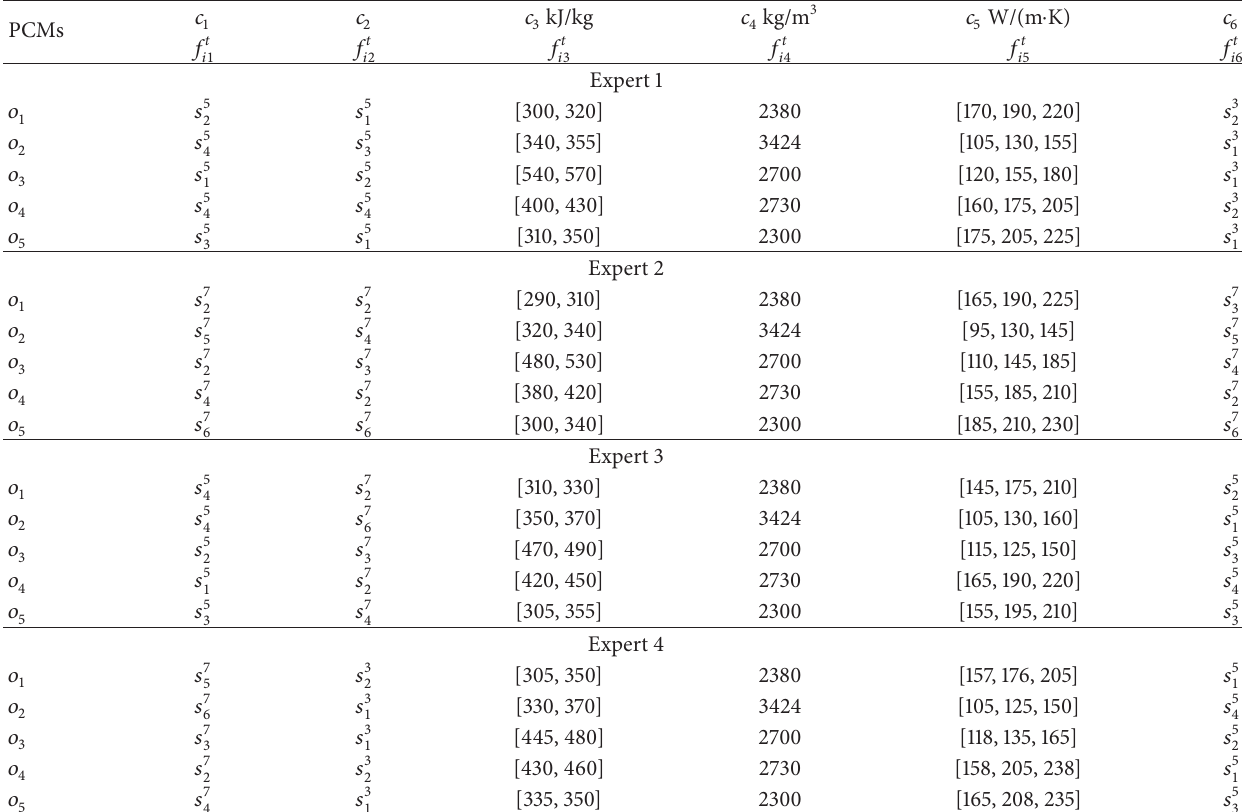
Table 2: Raw ratings on each attribute with respect to each alternative and each